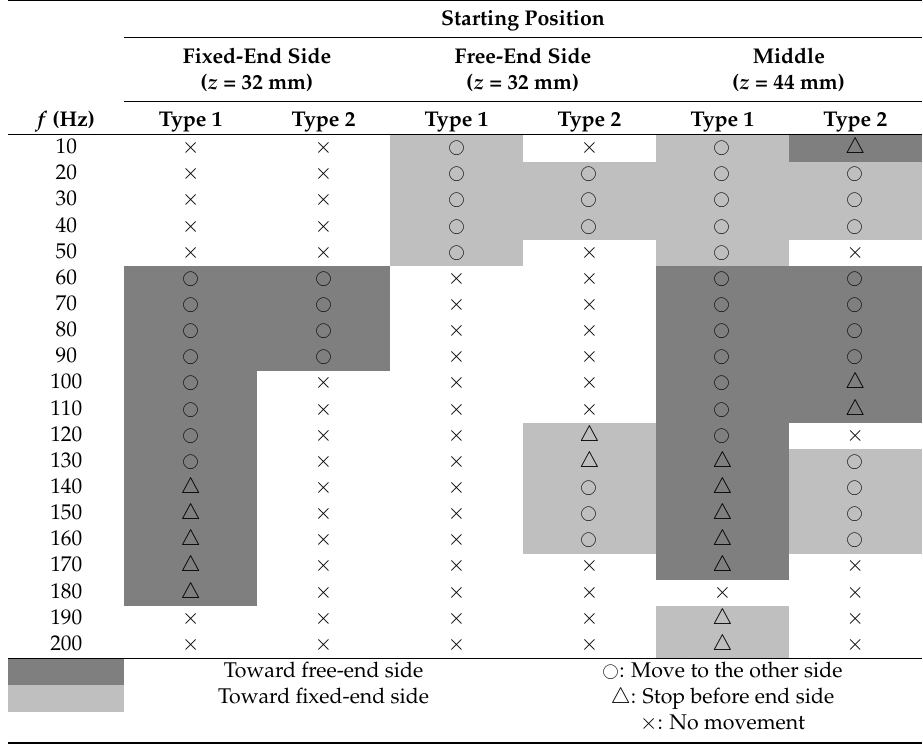
Figure 6. Output voltage versus time for the energy harvesting device with the proof mass ( f = 90 Hz, Types 1 and 2). Table 3. Movement of the proof mass corresponding to input